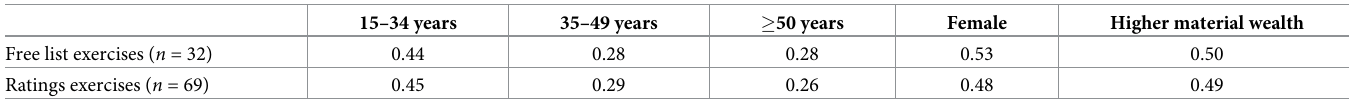
Table 1. Purposive life stage samples a